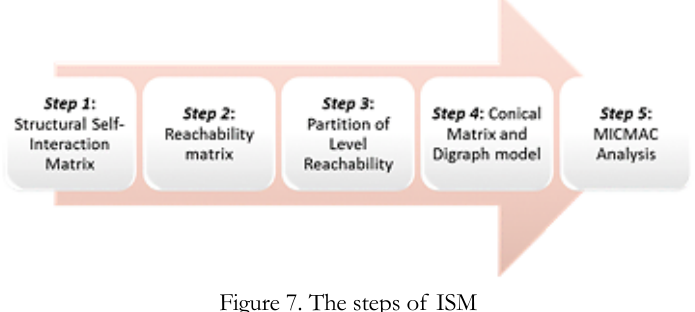
Figure 7. The steps of